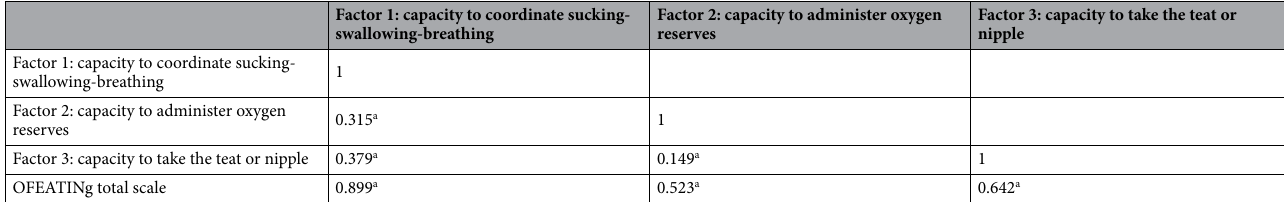
Table 4. Correlations OFEATINg: subscales and total scale. a All correlations are significant. Significance level: p < 0.01.